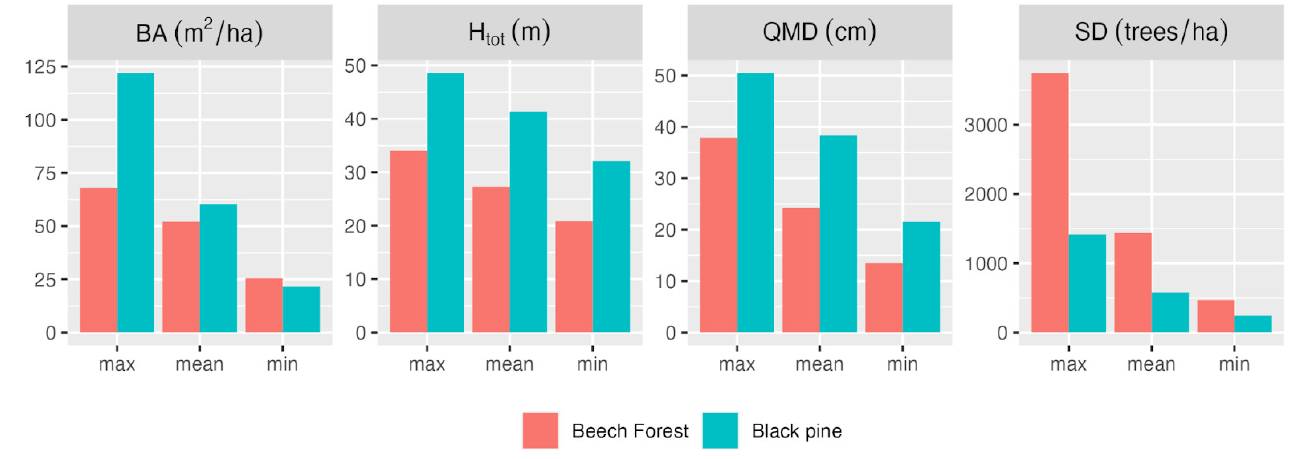
Figure 2. Summary plot-level attributes by dominant forest type: basal area (BA), total tree height (H tot ), quadratic mean diameter at breast height (QMD), stem density (SD).